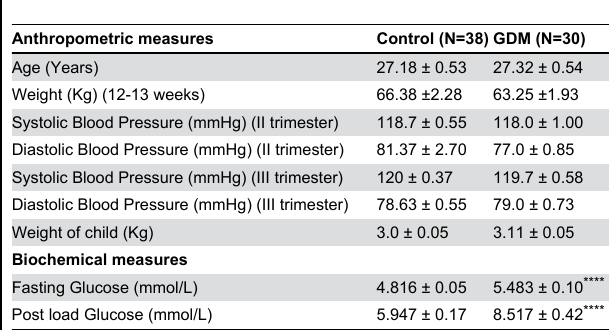
Table 1. Anthropometric and biochemical characteristics of study